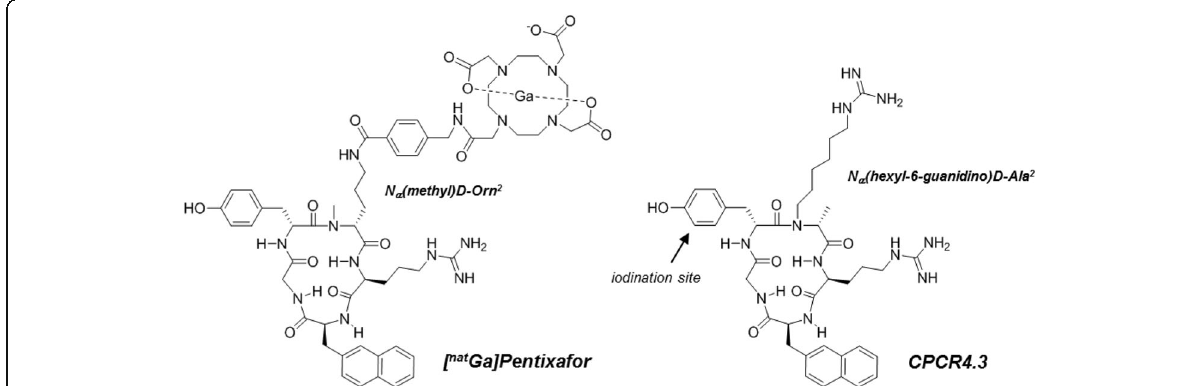
Fig. 1 Structures of [ nat Ga] Pentixafor and CPCR4.3; please note the central structural modification introduced into the peptide backbone, i.e. the shift of the functionalized alkyl chain from C α of D -Orn 2 (in Ga-Pentixafor) to N α of D -Ala 2 in